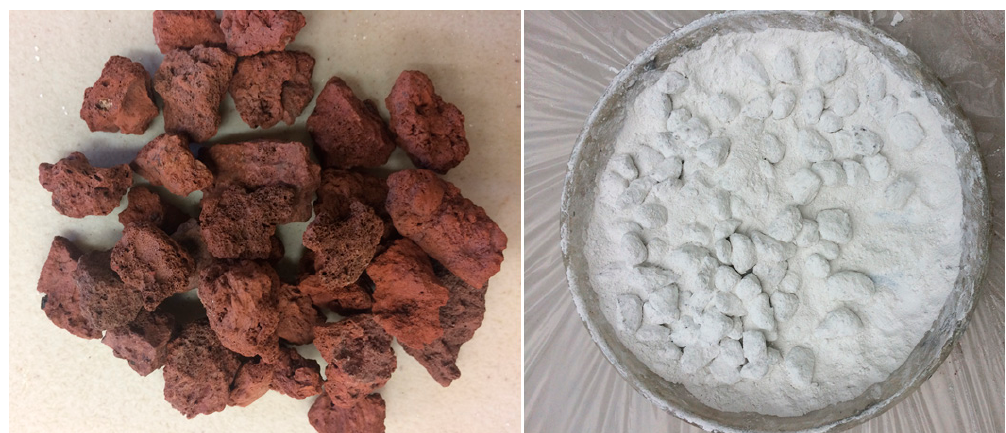
Figure 14. Scoria before and after coating.